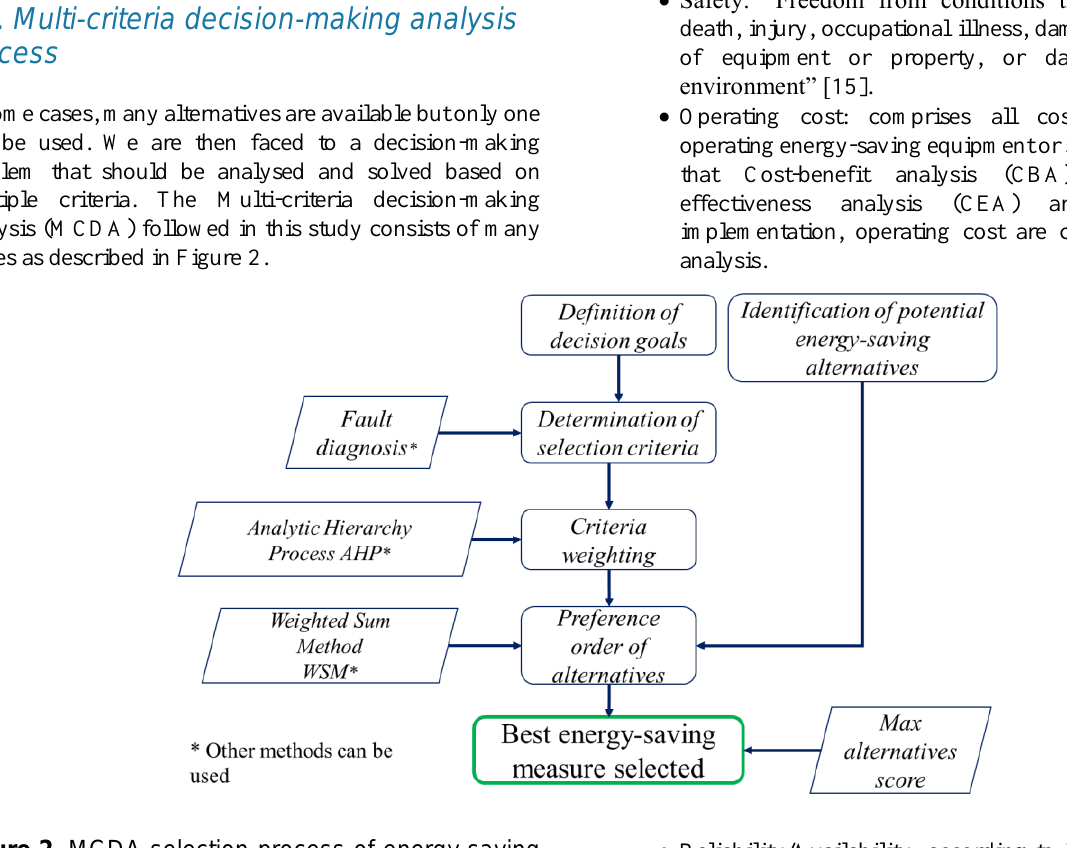
Figure 2. MCDA selection process of energy-saving measures